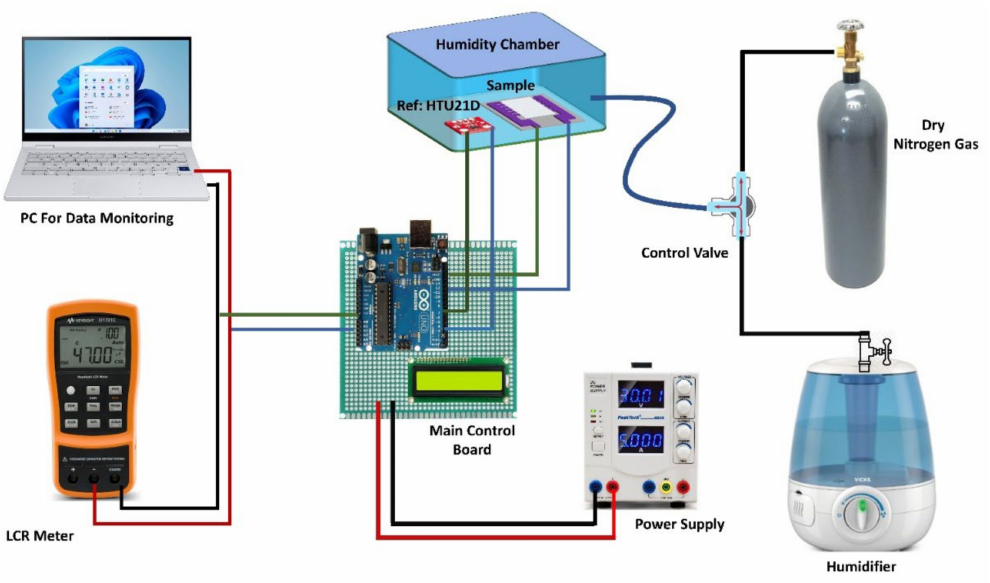
Figure 2. Custom made Experimental setup used to perform all Electrical